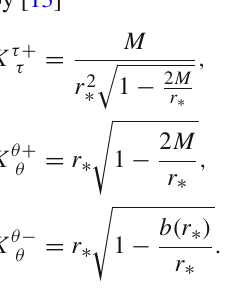
of the wormhole coincides with the Schwarzschild mass